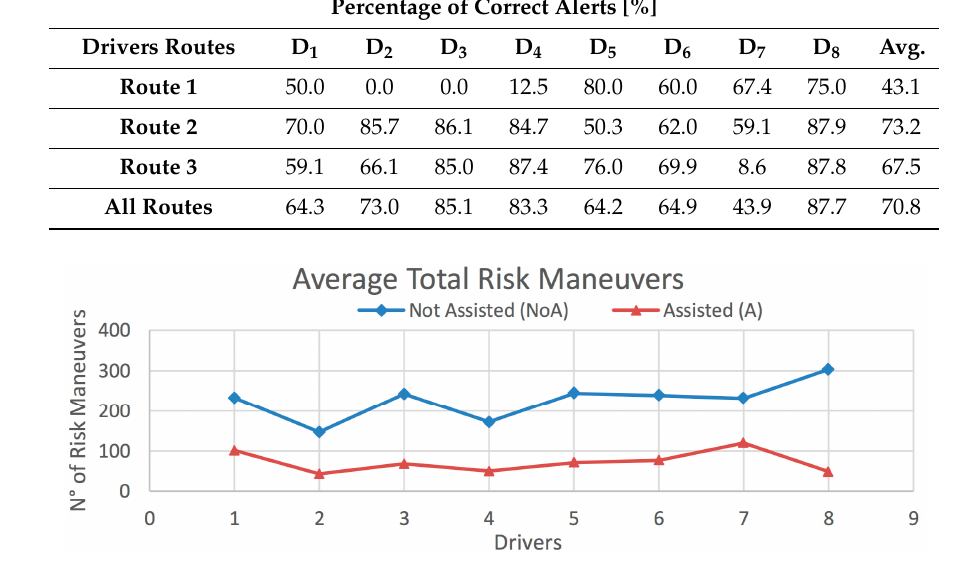
Figure 17. Average total risky maneuvers on all routes for all vehicles ( V 1 & V 2 ). Table 8. Decrease percentage of risky maneuvers on all routes for all vehicles ( V 1 & V 2 ) .